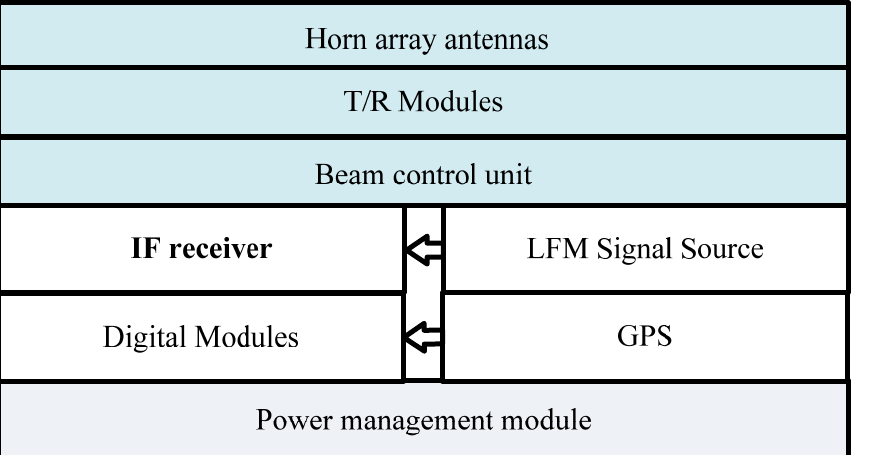
Figure 3. The diagram of the integrated phased array mini-SAR.